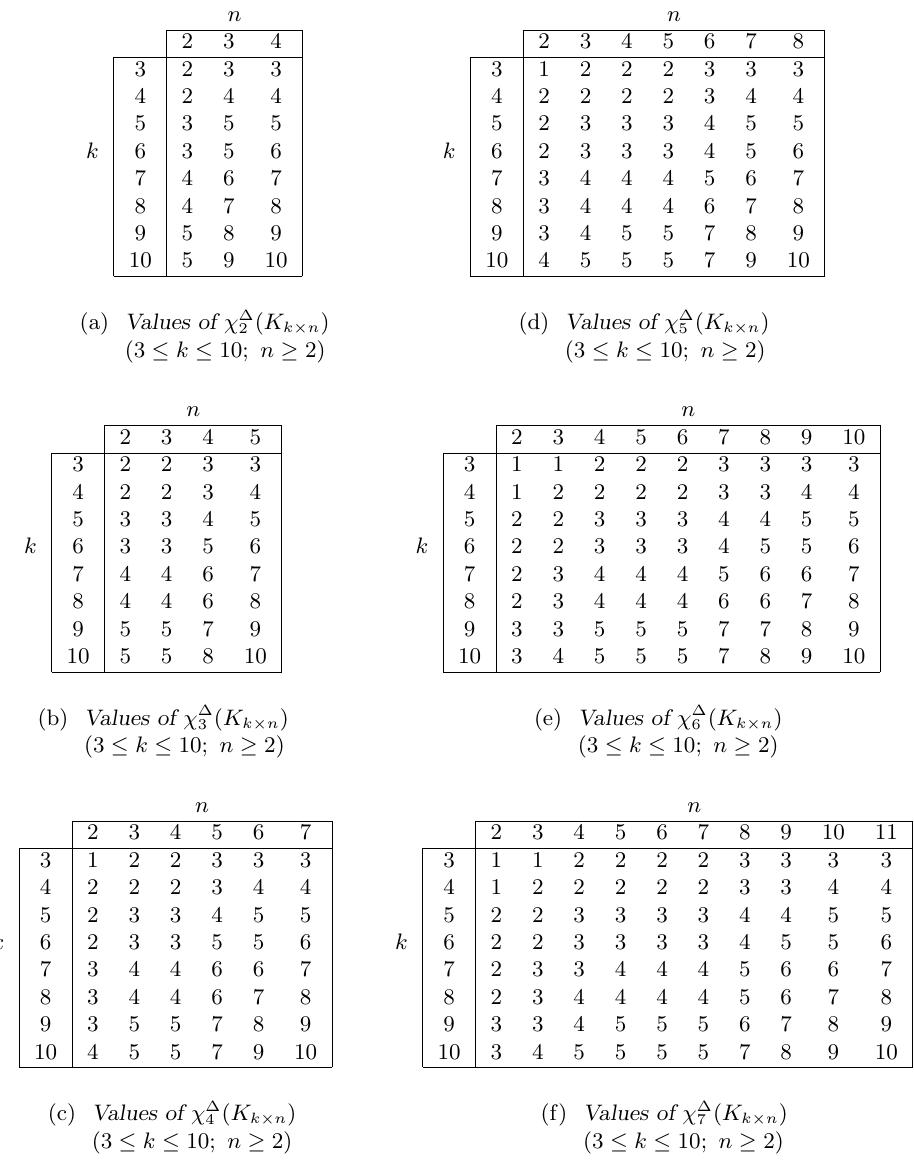
Values of χ ∆ ( K k × n ) , 3 ≤ k ≤ 10 , n ≥ 2 for different values of d . Note that d